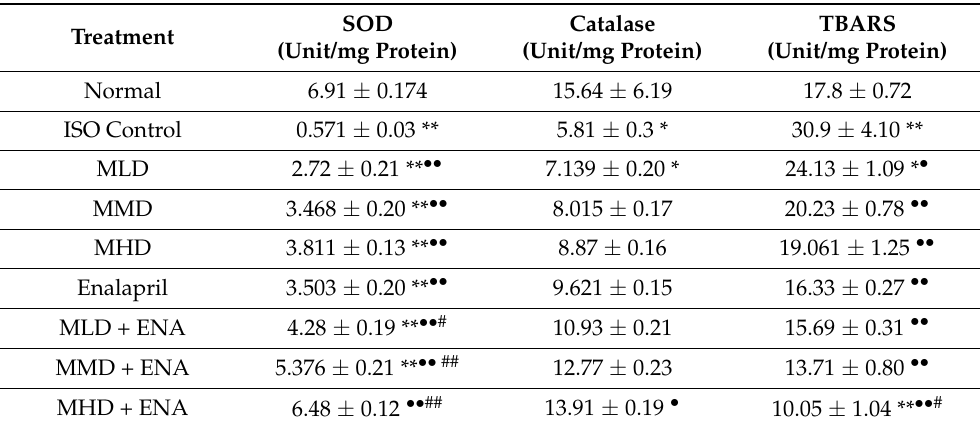
Table 4. Effects on SOD, catalase, and TBARS activity in heart tissue homogenate against isoprenaline- induced chronic myocardial